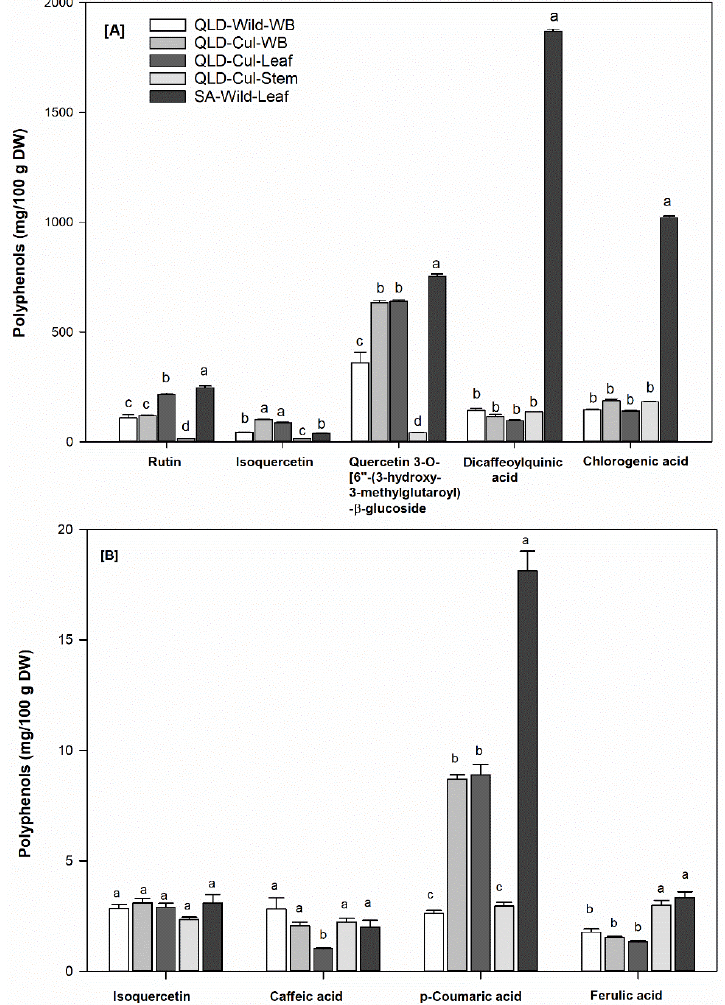
Figure 3. Free ( A ) and bound ( B ) phenolic compounds in the studied P. angustifolium samples; Data present means ± SD ( n = 3); Different letters of individual phenolic compounds indicate significant differences at α = 0.05.